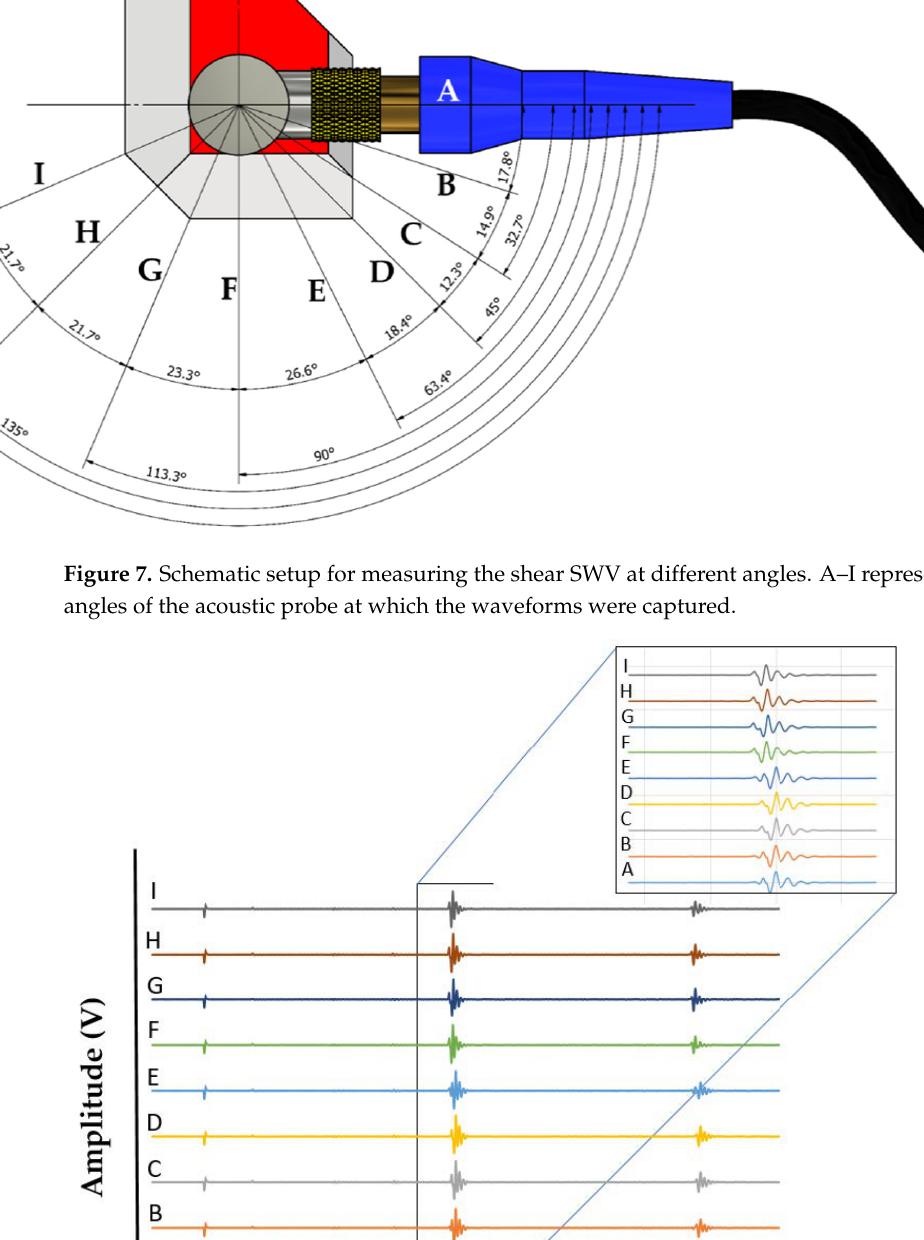
Figure 9. Nine shear sound waves at different angles (A–I) in the wrought alloy sample. The first and second echoes are evident. The zoom-in reveals the appearance and disappearance of the first and second reflection waves.